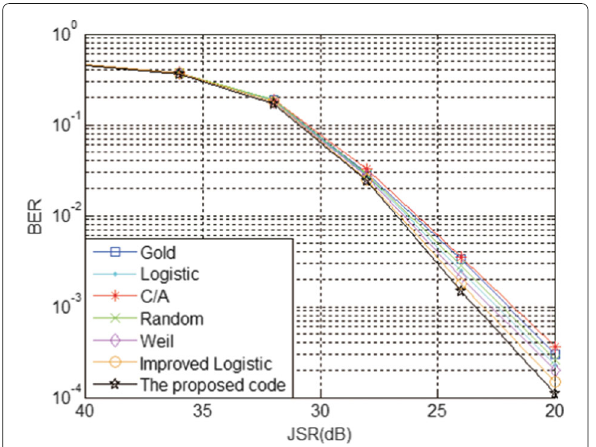
Fig. 10 BER curve of ranging codes with JSR under noise FM jamming